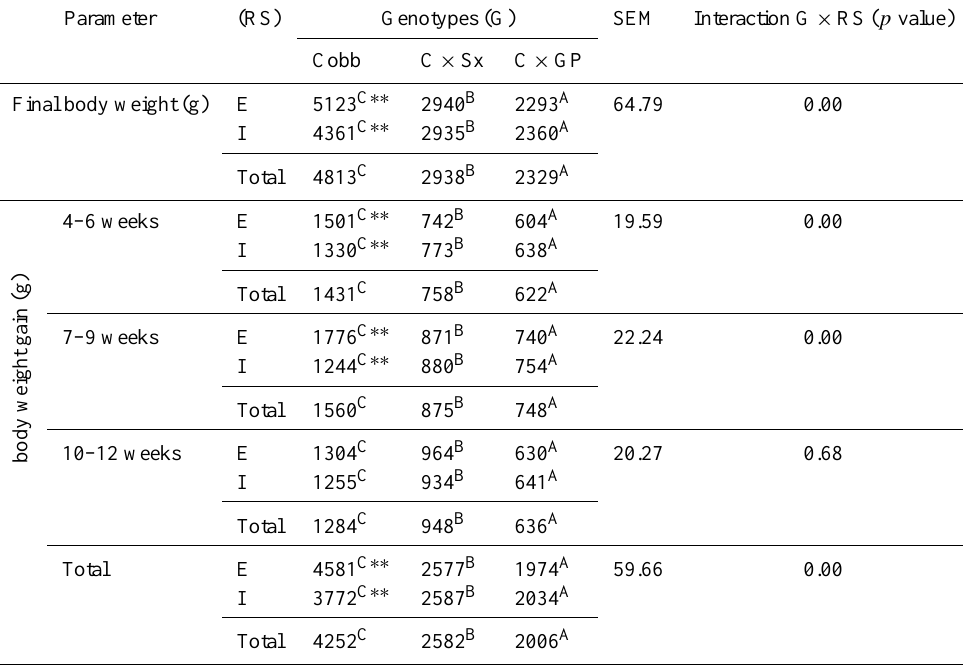
Table 4. Body weight gains of birds in particular feeding